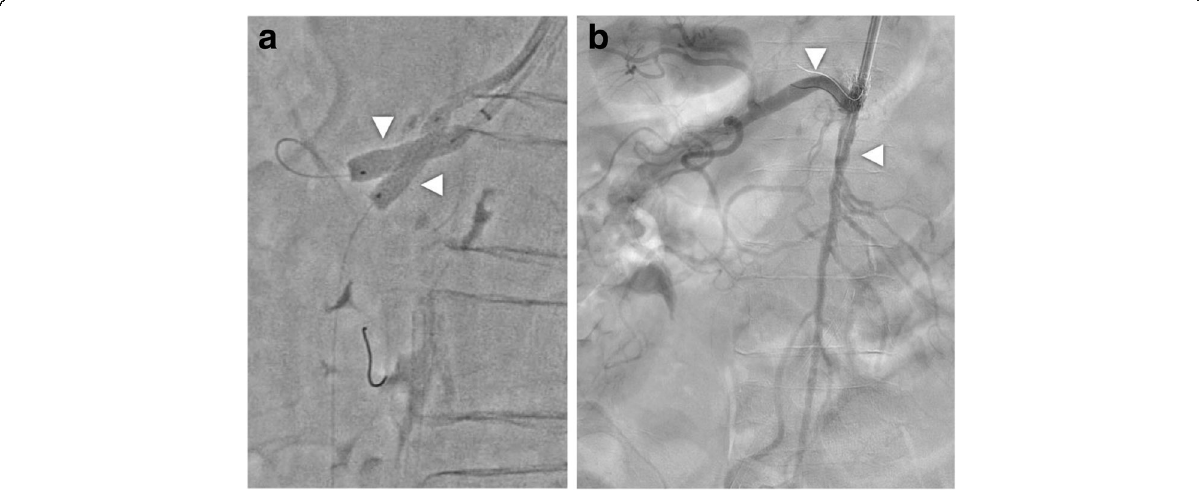
Fig. 3 Stenting to the SMA and the common hepatic artery with the kissing stent technique was performed ( a ). The final angiography showed satisfactory circulation to the SMA and the common hepatic artery ( b )